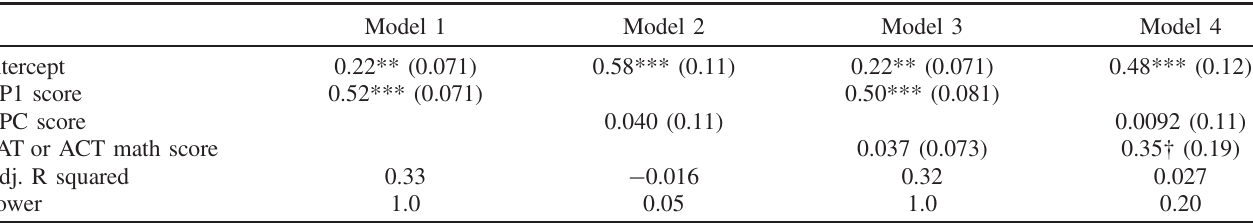
TABLE III. Regression model of FMCE scores on students ’ AP physics exam scores and SAT or ACT math scores. * p < 0 . 05 , ** p < 0 . 01 , *** p < 0 . 001 .